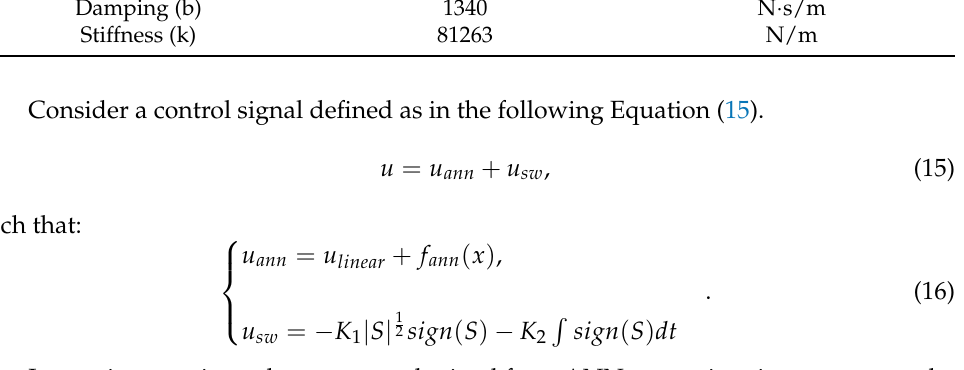
Table 2. Mechanical properties for the PEA. Values Units Mass (m) 0.431 Kg Damping (b) 1340 N · s/m Stiffness